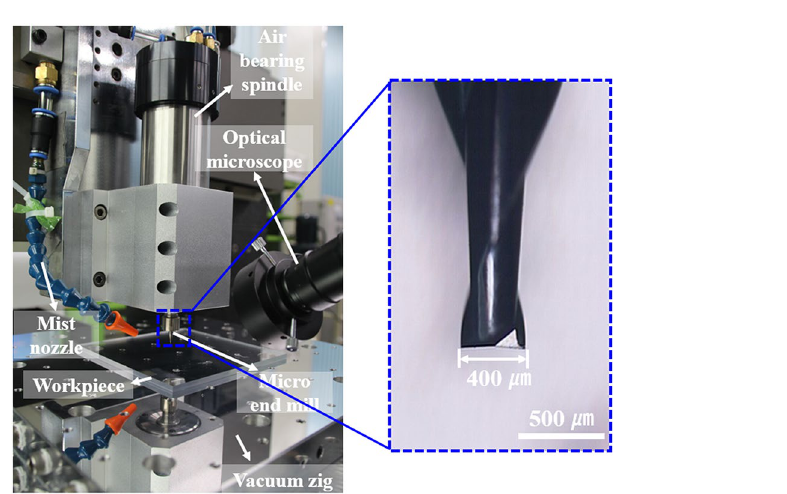
Figure 6. The micro-end-milling system for engraving of double square loop arrays on the PMMA workpiece and the cutting tool of TiAlN coated solid carbide.